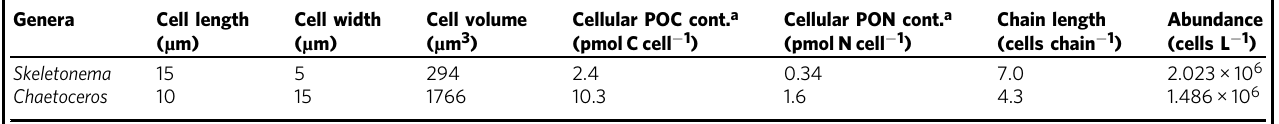
Table 1 Characteristics of Skeletonema and Chaetoceros Genera